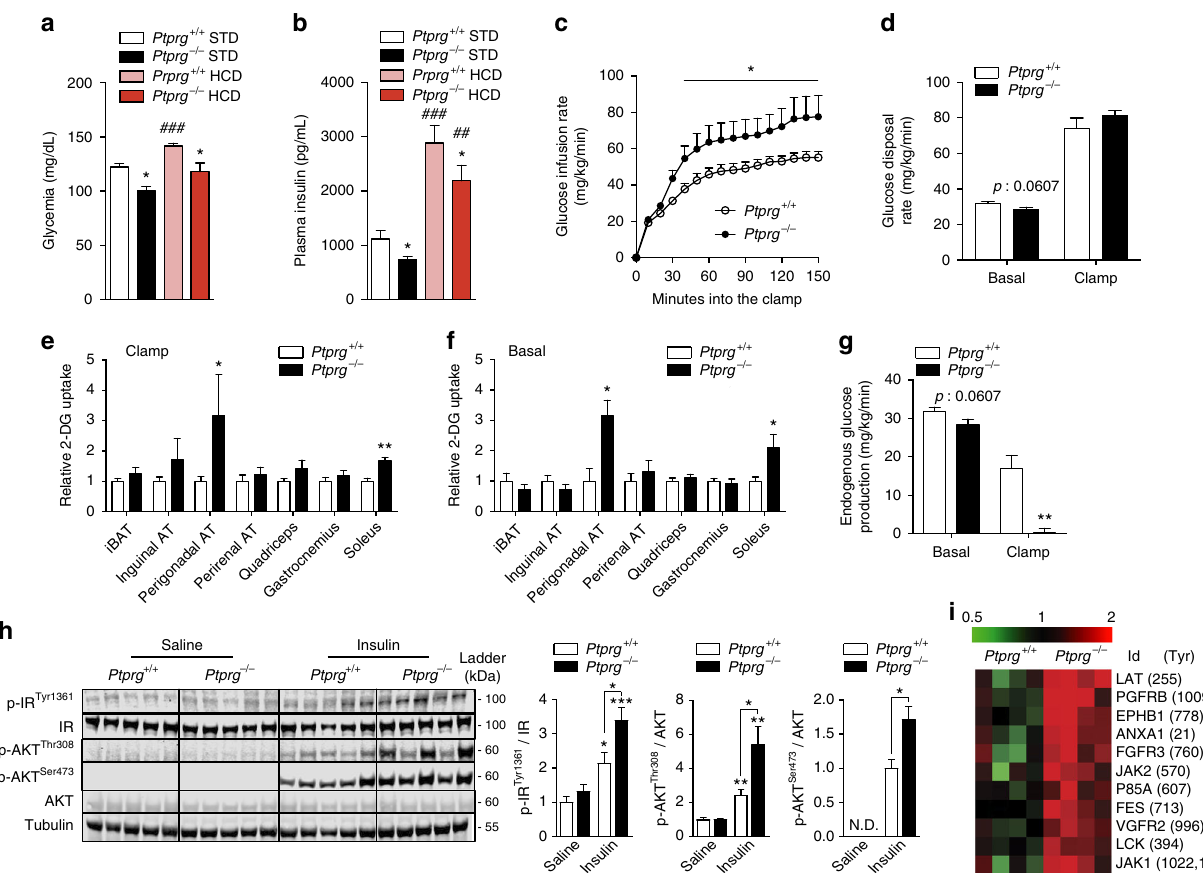
Fig. 2 Lack of PTPR- γ improves insulin sensitivity. a Circulating glucose and b insulin level in 30-week-old Ptprg + / + ( n = 8) and Ptprg − / − ( n = 6) mice fed either on a STD or a HCD. c Glucose infusion rate over time in clamp condition, d glucose disposal rate, e , f peripheral tissues glucose disposal and g endogenous glucose appearance rate in basal and clamp condition in 12-week-old Ptprg + / + ( n = 6) and Ptprg − / − ( n = 6) mice fed on a STD. h Immunoblot of the described total and phosphorylated proteins in the liver of 10-week-old STD-fed Ptprg − / − and Ptprg + / + mice 10 min after an intraperitoneal injection of either insulin (5 units/kg of body weight) or saline. On the right, panels represent relative protein quanti fi cation ratios. i Hit-map representing phosphorylation at speci fi c tyrosine residues (values are obtained from data shown in Supplementary Table 1 and represent changes between Ptprg − / − and Ptprg + / + mice that are greater than 1.5 fold and of statistical signi fi cance ( t -test: p values < 0.05). Error bars represent SEM. Statistical analyses were done using two-tailed unpaired Student ’ s t test or using one-way ANOVA (Tukey ’ s post test). * P < 0.05, ** P < 0.01; ## P < 0.01, ### P < 0.001. In a and b the * P values are calculated by comparing values gathered from mice of different genotype fed on the same diet; ## P < 0.01, ### P < 0.001, these values were calculated by comparing data from HCD-fed mice of either genotype vs. STD-fed Ptprg + / + mice. In h , * P values are calculated by comparing values